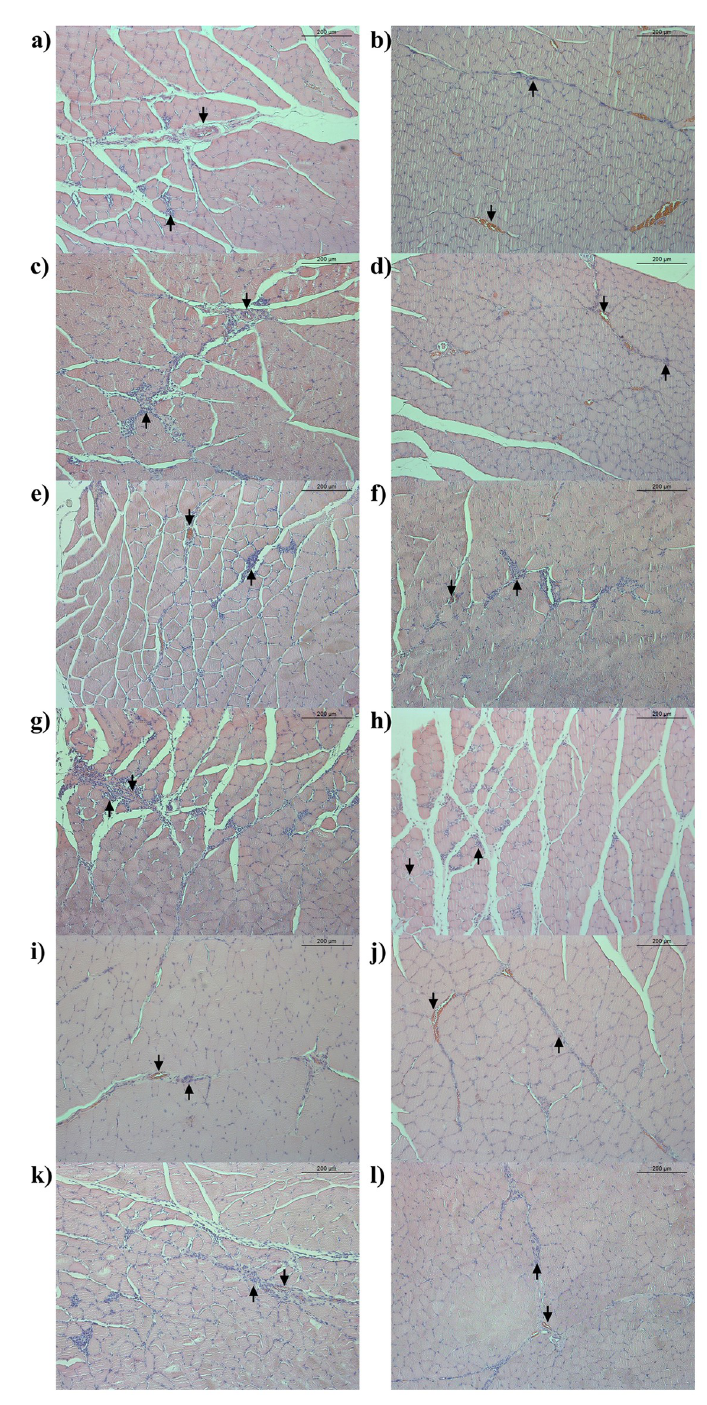
Fig 2. Histopathological section of the administration site in the four-week repeated intramuscular dose toxicity study in Sprague-Dawley (SD) rats. Hematoxylin and eosin stained histopathological section (original magnification 100x) of the gastrocnemius muscle of the SD rats: a) Control group, male; b) Control group, female; c) Polysorbate 20– 0.02 mg/kg, male; d) Polysorbate 20–0.02 mg/kg, female; e) Polysorbate 20–0.1 mg/kg, male; f) Polysorbate 20–0.1 mg/ kg, female; g) Polysorbate 20–0.4 mg/kg, male; h) Polysorbate 20–0.4 mg/kg, female; i) Human serum albumin-0.06 mg/kg, male; j) Human serum albumin-0.06 mg/kg, female; k) Human serum albumin-0.12 mg/kg, male; l) Human